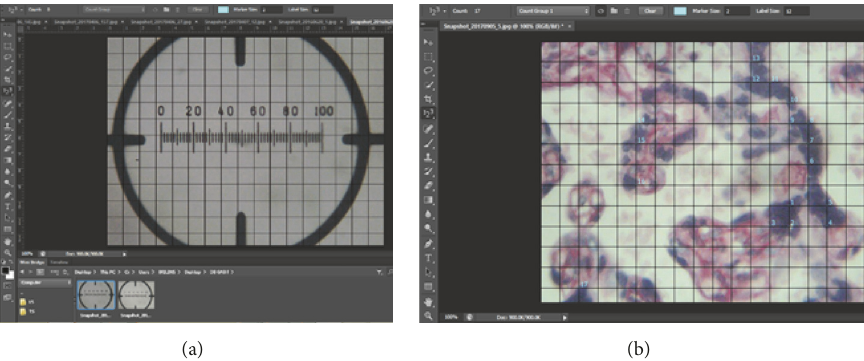
Figure 2: (a) Grid being calibrated using Adobe Photoshop. (b) Point counting of syncytial knot using Adobe